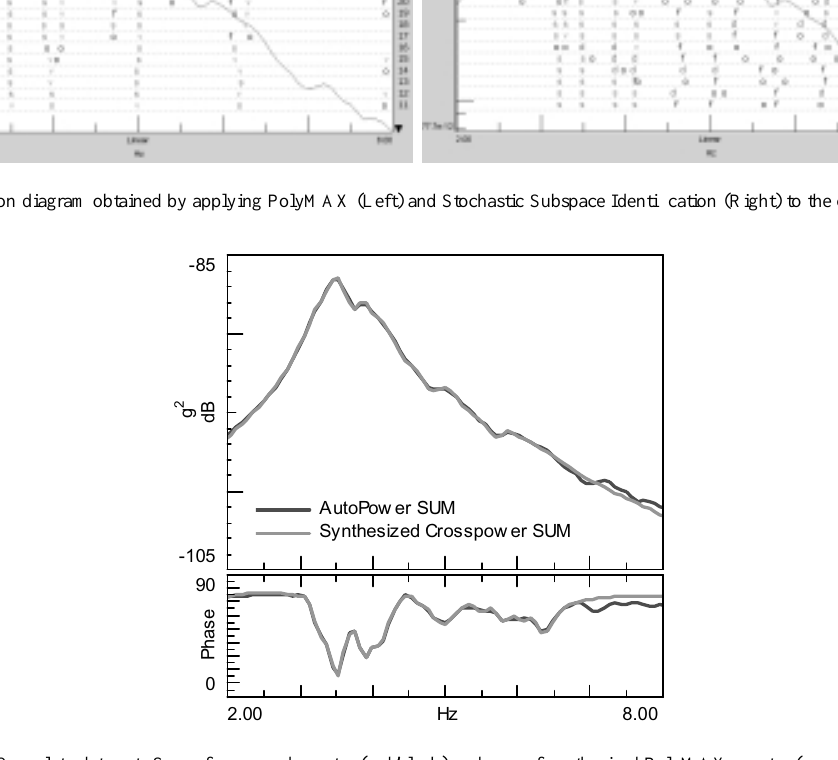
Fig. 8. Complete data set: Sum of measured spectra (red/black) and sum of synthesised PolyMAX spectra